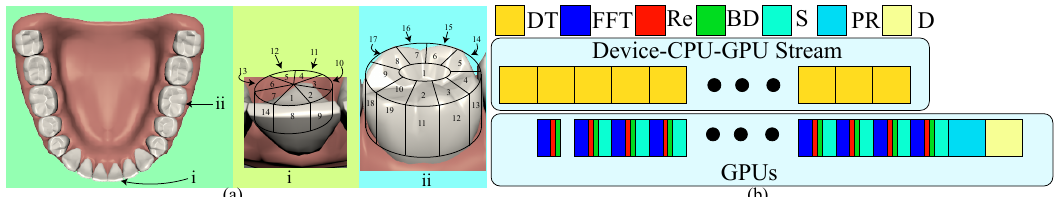
parallel streams: data transfer and GPU computation. While transferring a slice of scanning data (DT), GPUs also compute fast Fourier transform (FFT), optical rectification (Re), and boundary